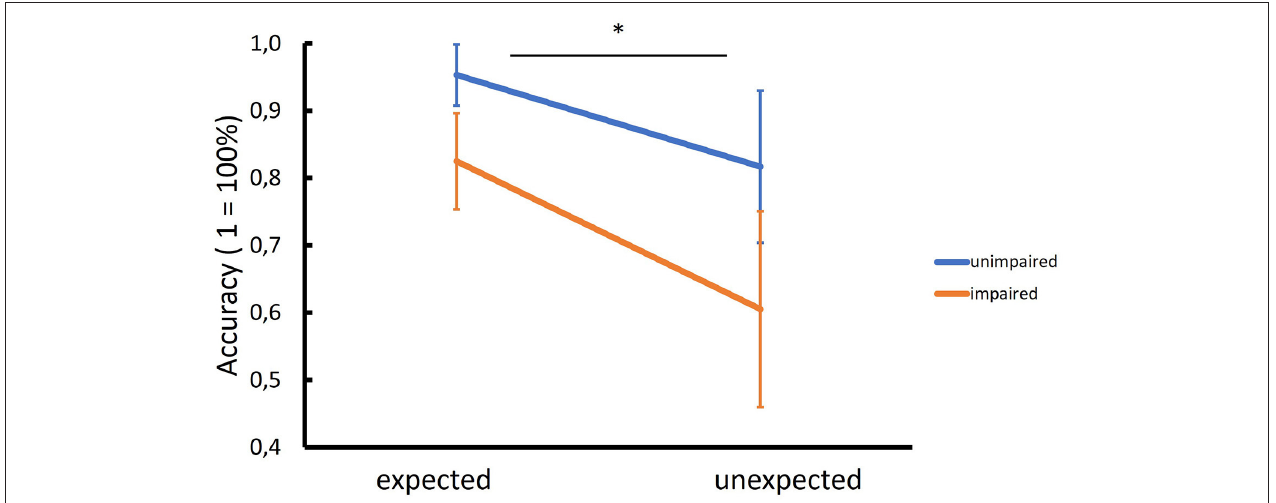
FIGURE 2 | Interaction between cognitive status and expectedness of the location of the target. While cognitively unimpaired MS patients had higher accuracy than impaired patients to detect targets in their expected positions (e.g., milk carton in the fridge), this difference was even more pronounced when the target was in an unexpected position (e.g., milk carton on the floor) (* = significant GLM interaction, p =